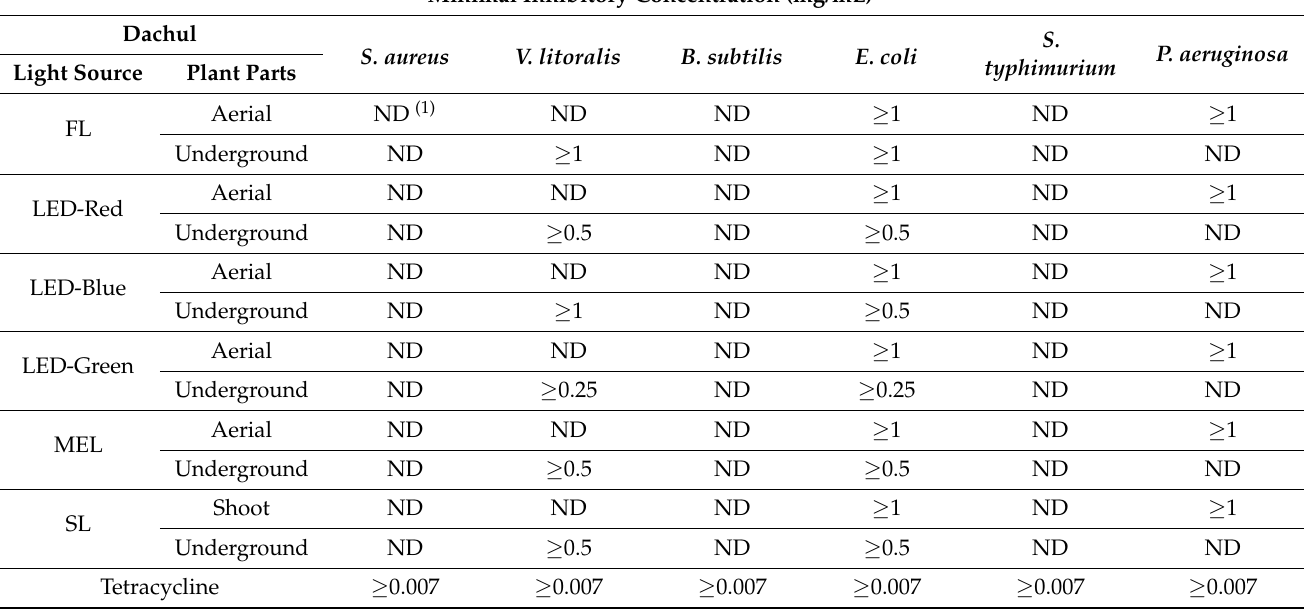
Table 2. Antimicrobial activity by parts of aerial and underground from extracts of A. macrocephala treated with artificial light sources for 2 weeks.